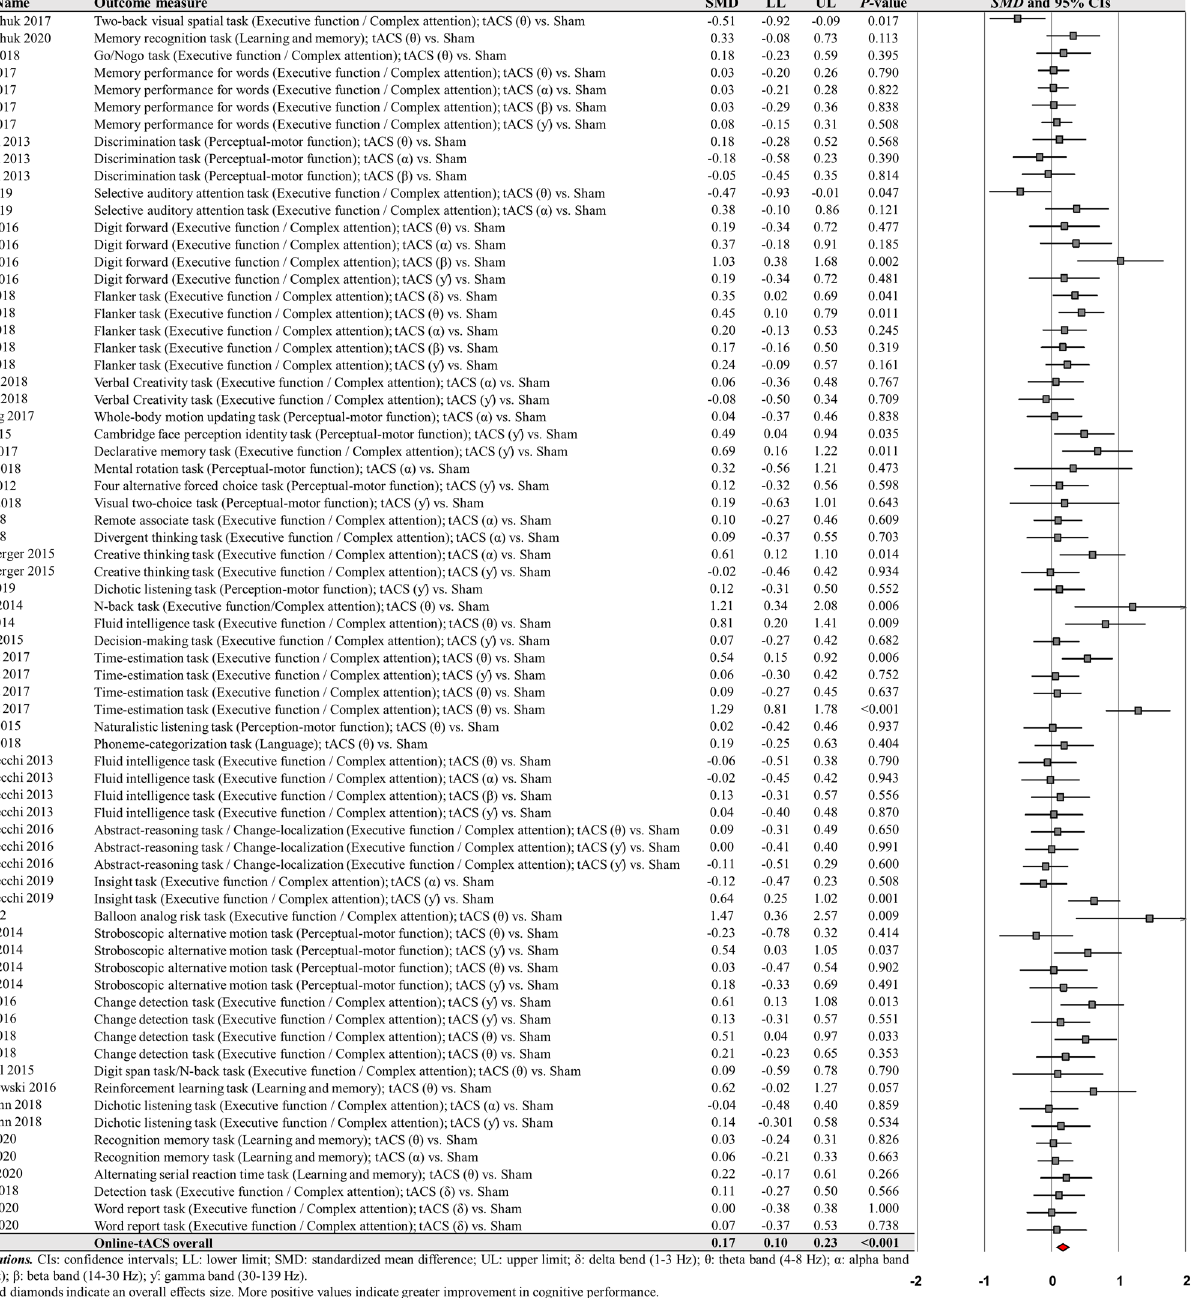
Fig. 3 Cognitive performance comparisons after online-tACS. Meta-analytic fi ndings show potential effects of online-tACS protocols on changes in cognitive